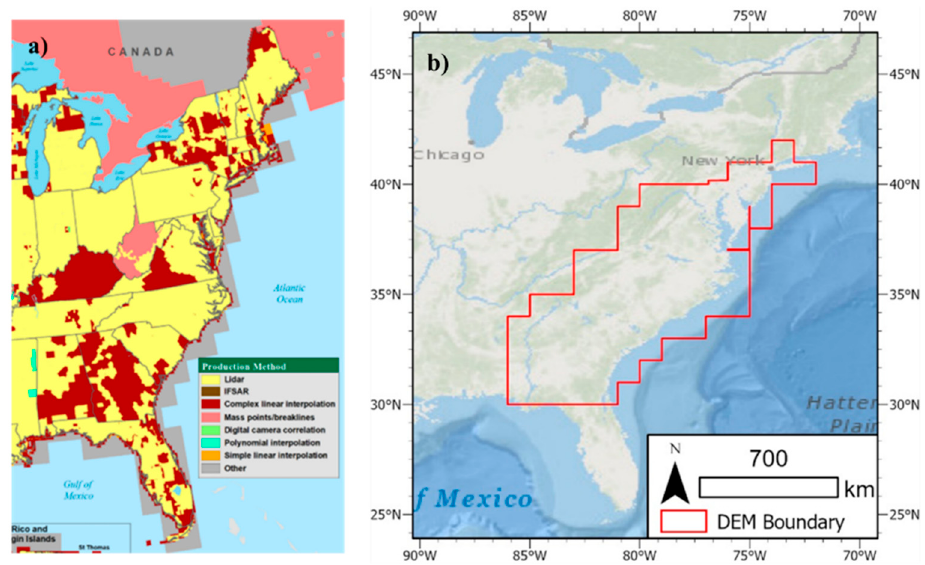
Figure 5. ( a ) National Map Elevation 10-m DEM availability by production method. ( b ) Boundary for mosaic of 10-m elevation data used for this study. for mosaic of 10-m elevation data used for this